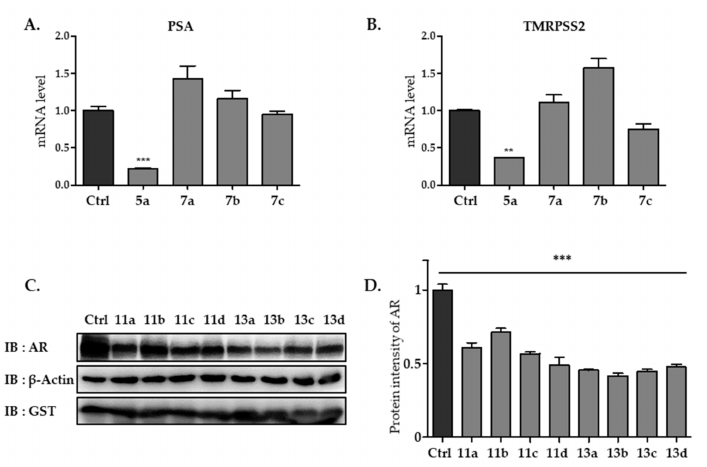
Figure 3. Effects of the novel AR antagonists and novel AR PROTACs. ( A , B ) mRNA levels of PSA and TMPRSS2 in LNCaP cells treated with AR antagonists 5a and 7a – c (10 µ M) (n = 3). ( C ) Effects of various AR PROTAC compounds (10 µ M) on the levels of ectopically expressed AR in HEK293T cells as determined by immunoblotting. ( D ) Quantitation of protein levels by the treatment of compounds using densitometry. The experiments were repeated at least three times. The data represent mean values ± SEM. *** p < 0.001, ** p < 0.01. Ctrl,